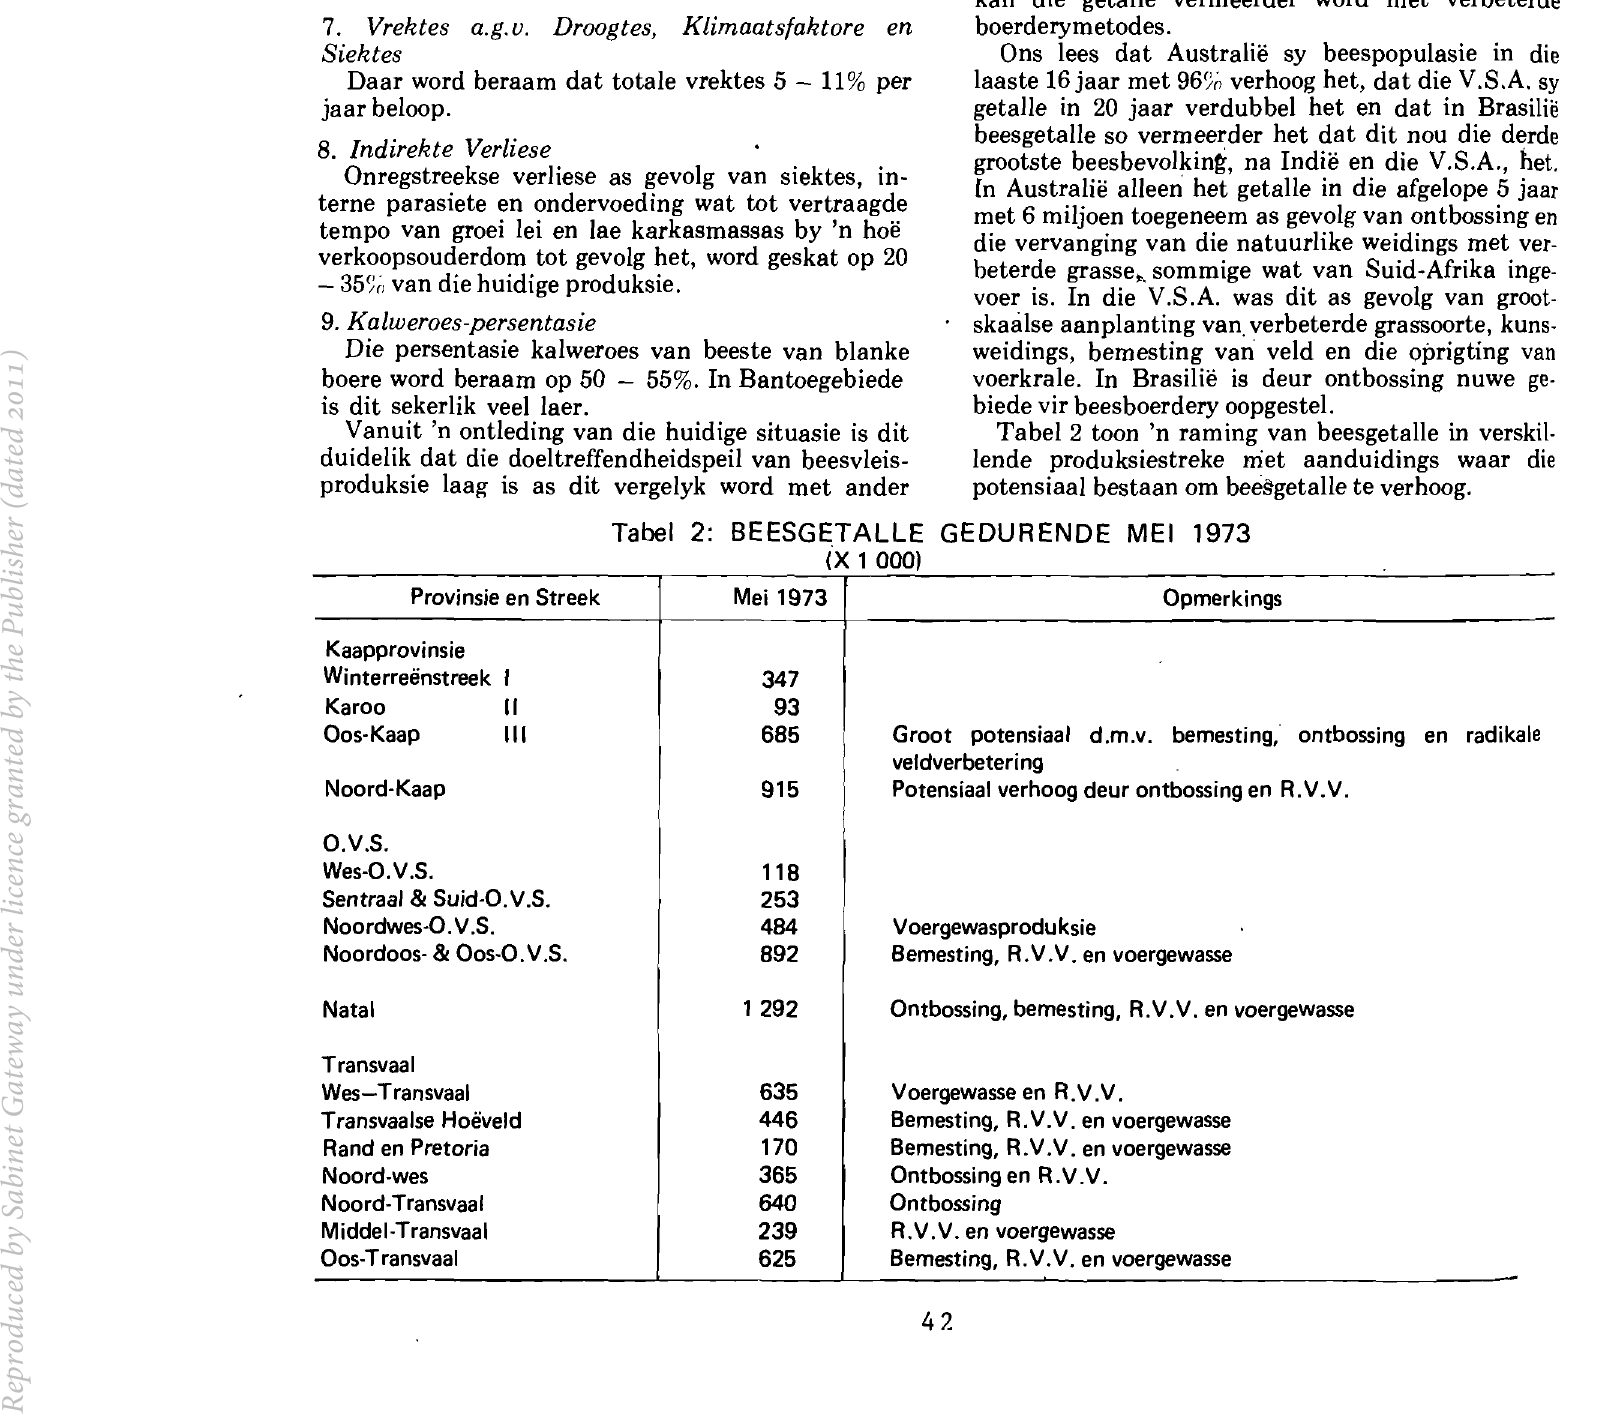
Tabel 2: BEESGETALLE GEDURENDE MEl